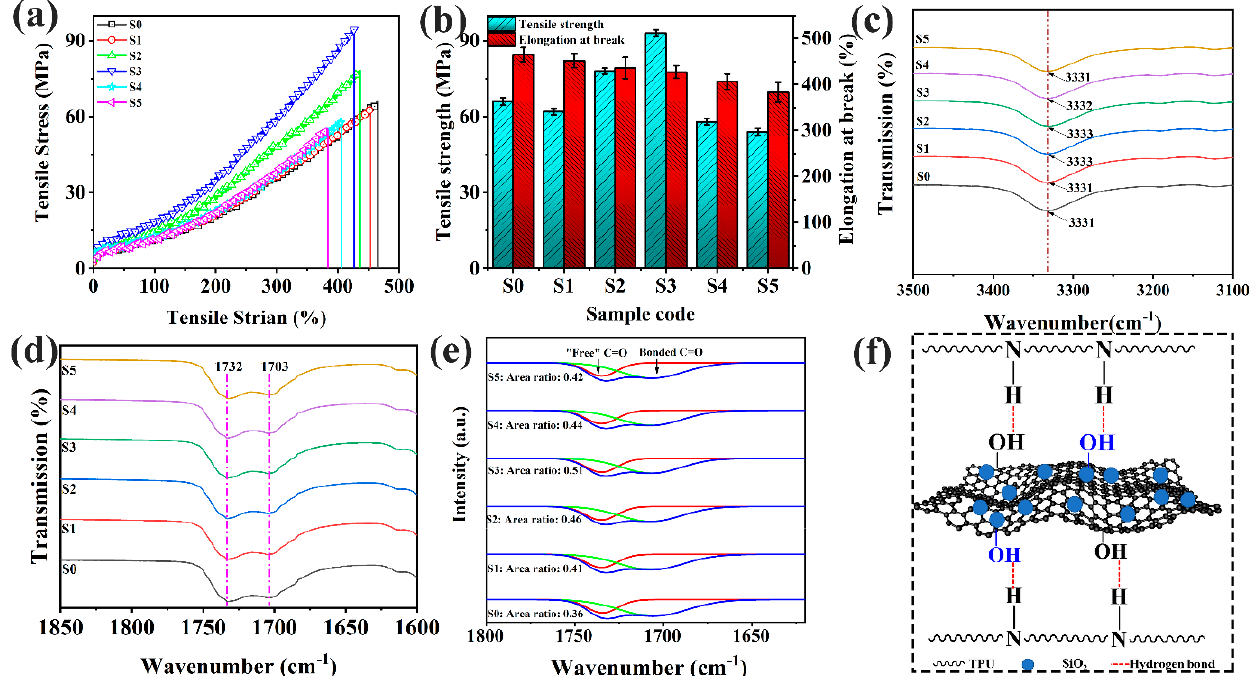
Figure 5. Mechanical properties of TPU nanocomposites: ( a ) stress − strain curves and ( b ) statistical results of tensile strength and elongation at break; FT − IR spectra of TPU composites at the range of ( c ) 3500 cm − 1 − 3100 cm − 1 , ( d ) 1850 cm − 1 − 1600 cm − 1 , ( e ) curve fitting diagram of the carbonyl stretching region ( f ) schematic diagram of the microstruc- ture of TPU